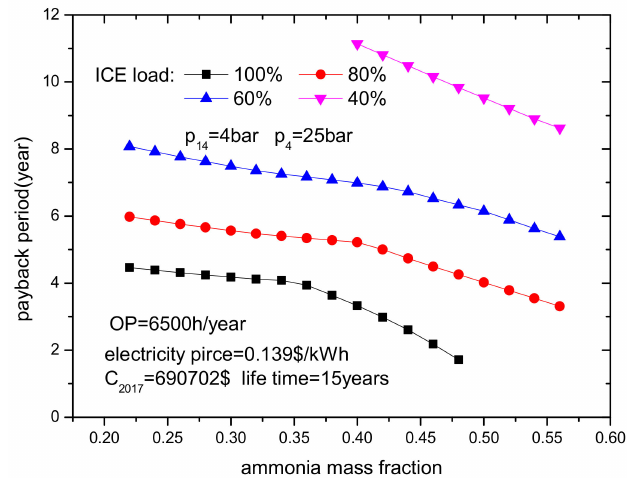
Figure 13. Effects of ammonia mass fraction on payback period.